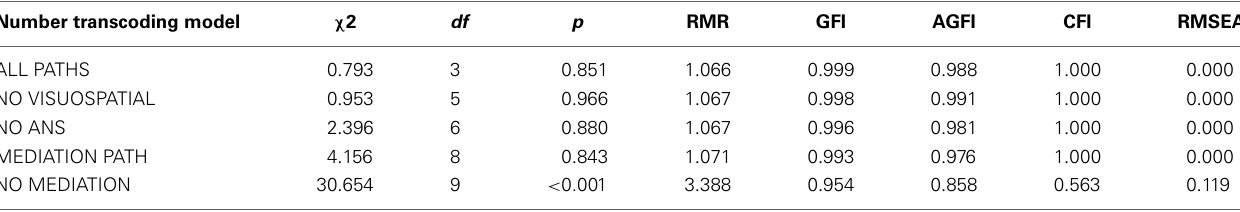
Table 3 | Fit statistics for path models regarding number writing